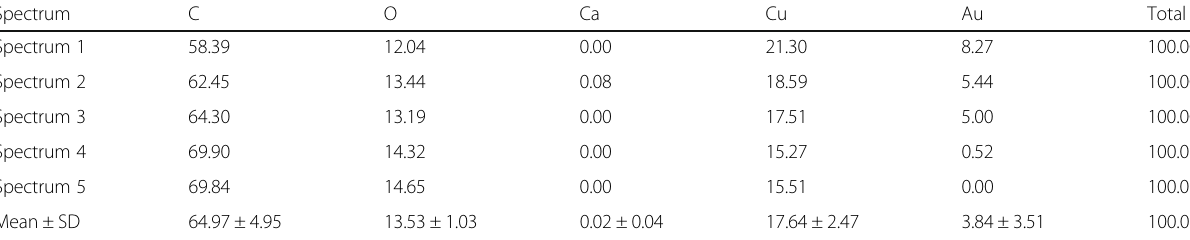
Table 1 EDX elemental composition profile of the Au-CSCaCO 3 NPs Spectrum